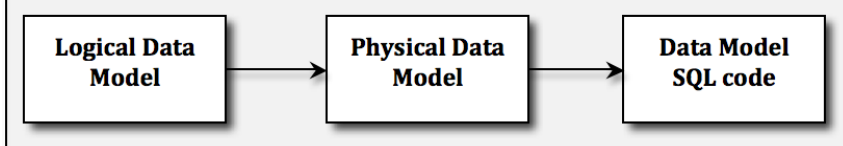
Figure 6. Data Model transformation